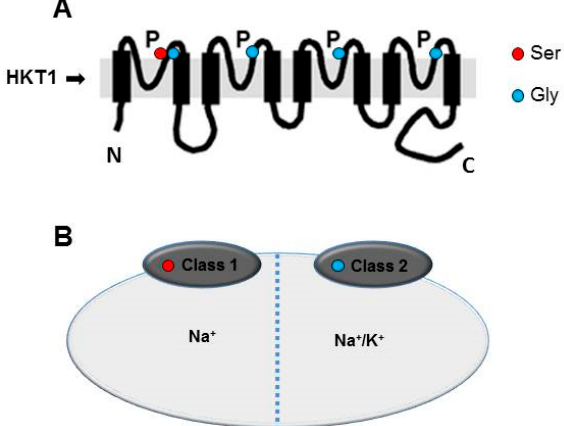
Figure 1. Classification and structure of HKT1 proteins. ( A ) Structural analysis of HKT1 protein containing Ser or Gly residues in their conserved regions. Members of class-1 transporters carry a Ser in the selectivity filter position while on the same position class-2 transporters contain a Gly residue. P denotes pore-loop domain while N and C indicate N-terminus and C-terminus of HKT-proteins. ( B ) Members of class-1 HKT1 that carry a Ser residue transport Na + while members of class-2 that carry a Gly residue can transport both Na + as well as K +